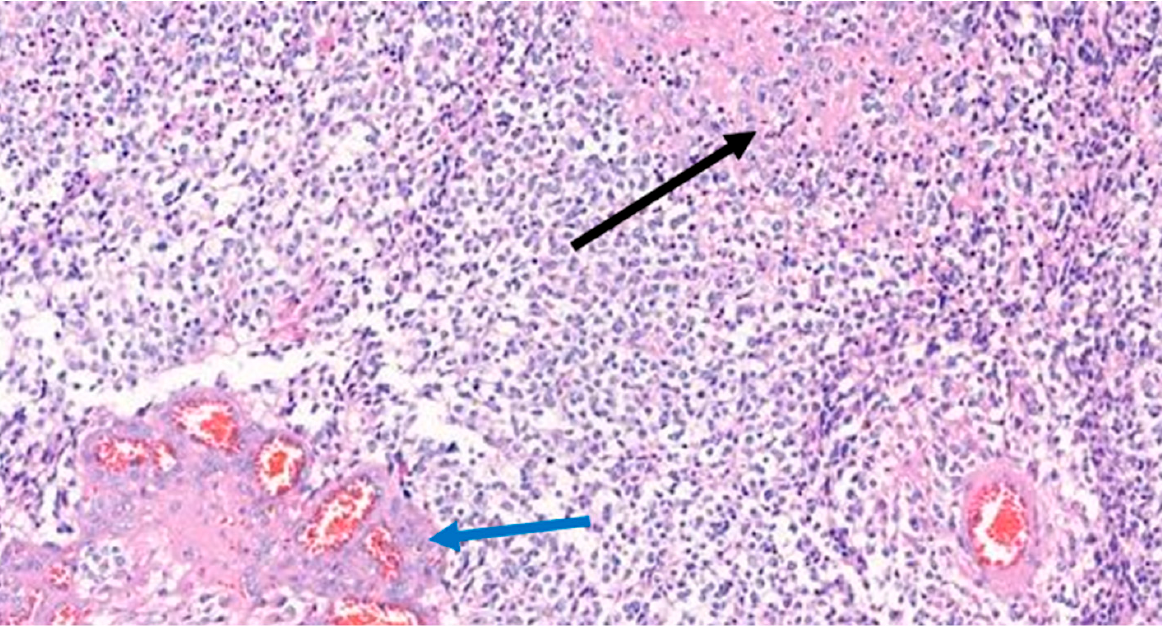
Figure 5. Histological examination of the tumor. The neoplastic cells had nuclear enlargement where hyperchromatic nuclei could be observed. The black arrow shows geographic necrosis, and the blue arrow shows microvascular proliferation. Hematoxylin and eosin stain, magnification 200×.